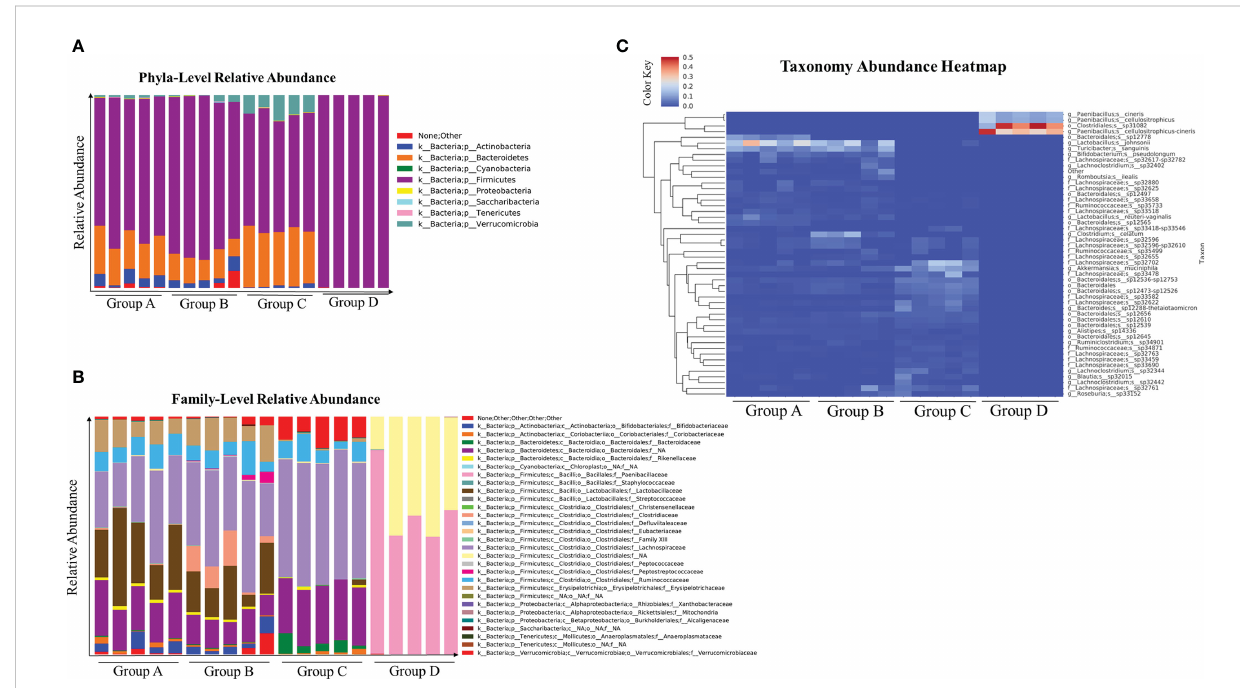
FIGURE 2 Microbial composition at taxonomical level and abundance heatmap of gut microbial community in the cecal contents of uninfected and C. auris infected mice were shown here. Groups of mice treated with sterile water or cefoperazone containing water for 7 days were infected with and without C. auris . Group A (received sterile water without C. auris infection), Group B (received sterile water with C. auris infection), Group C (received antibiotic water without C. auris infection), and Group D (received antibiotic water with C. auris infection). Relative abundance of major phyla (A) and family level abundance (B) , taxonomical abundance heatmap with top fi fty abundant microbial species (C) among all four groups were plotted. The relative abundance score ranges from 0 to 0.5. Five mice per group was used for microbiome